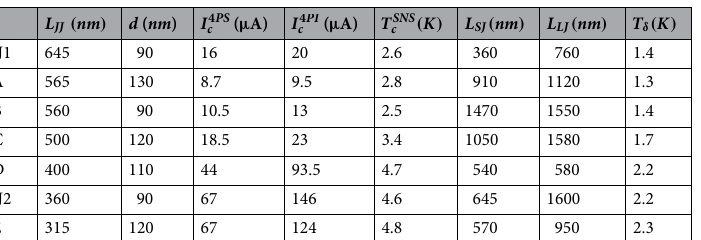
Table 1. Main parameters of studied devices. From left to right: Sample names, length L JJ and diameter d 4 PS I 4 PI of NW, critical currents I c and c measured in 4PS and 4PI schemes, critical temperature superconducting transition, lengths of the shortest L SJ and longest L LJ side junctions, temperature T δ (defined in the